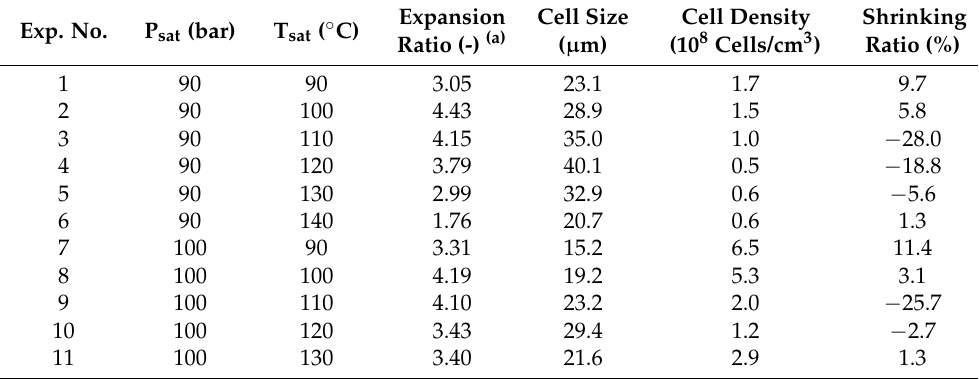
Figure 6. Effect of saturation condition on the expansion ratio of microcellular foam of TPU: ( a ) effect of saturation pressure, ( b ) effect of saturation temperature.